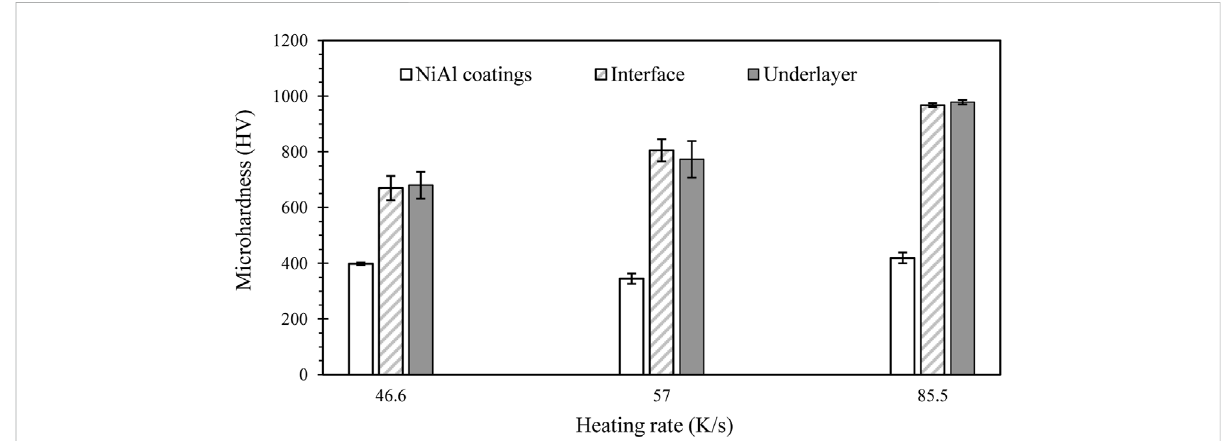
FIGURE 5 Microhardness across the coating, interface, and underlayer with different heating rates.